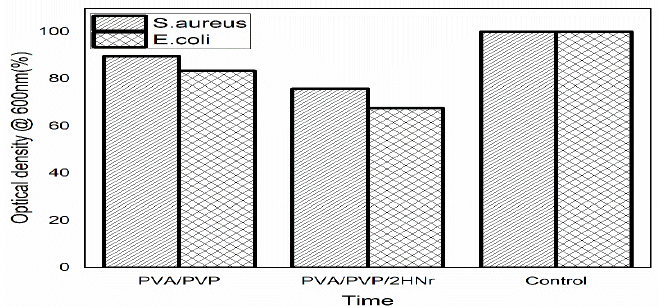
Figure 7 . Antibiogram of PVA/PVP and PVA/PVP/2HNr hydrogel against Gram ‐ negative Esche ‐ Figure 7. Antibiogram of PVA/PVP and PVA/PVP/2HNr hydrogel against Gram-negative Es- richia coli, Gram ‐ positive Staphylococcus aureus. cherichia coli , Gram-positive Staphylococcus aureus .